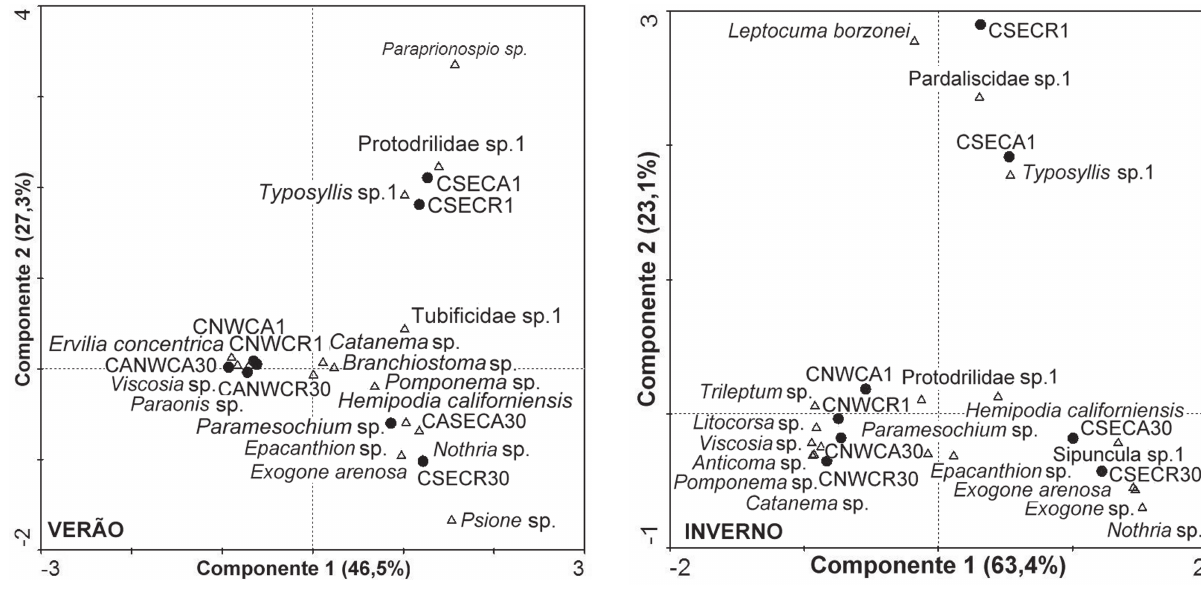
Figuras 7-8. Resultado da análise de Correspondência da infauna da Ilha Currais (C) no verão (7) e no inverno (8), nas faces exposta (SE) e protegida (NW); nas cristas (CR) e cavas (CA); nos distanciamentos de 1 e 30